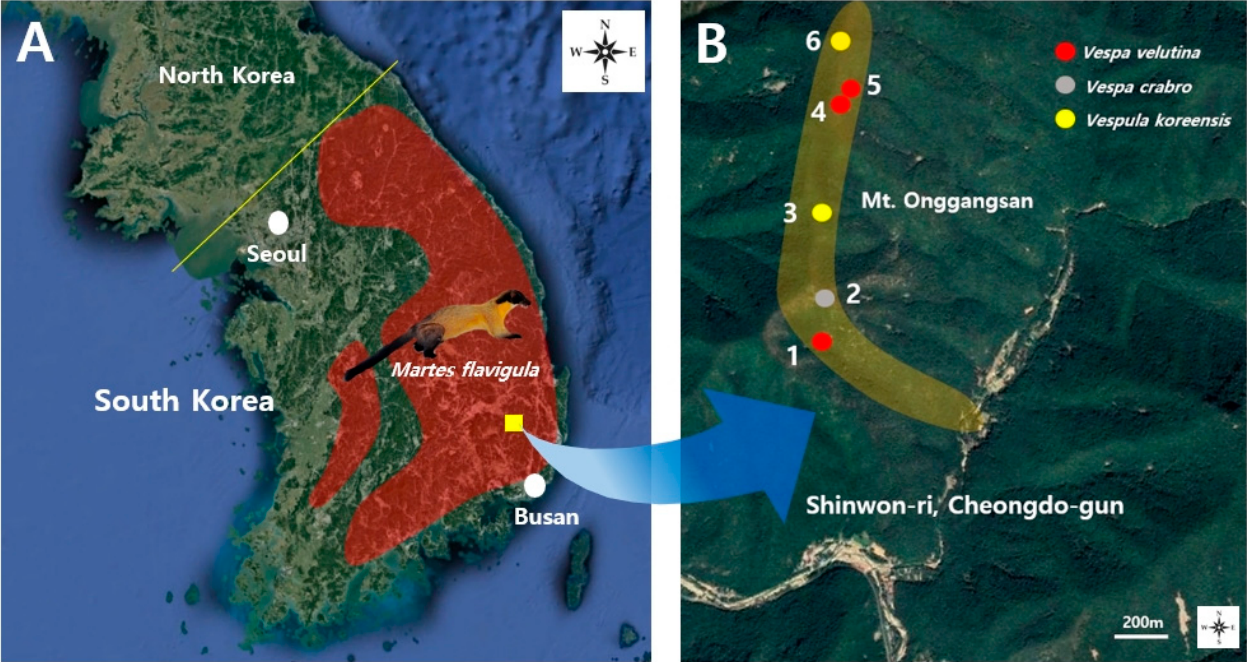
Figure 1. Distribution area of the yellow-throated marten (YTM) in South Korea and the survey area. ( A ) YTM habitat area distributed along the southeastern mountainous area of South Korea (red area) (modified from [59]). ( B ) The location of YTM feces where wasp debris was detected in the area of Mt. Onggangsan, Sinwon-ri, Cheongdo-gun. Yellow area: survey area (see Table 1 for collection points). Table 1. Location information for the yellow-throated marten (YTM) fecal samples containing wasp debris and the iden- tified species, caste, and number of individuals between October and December 2019.